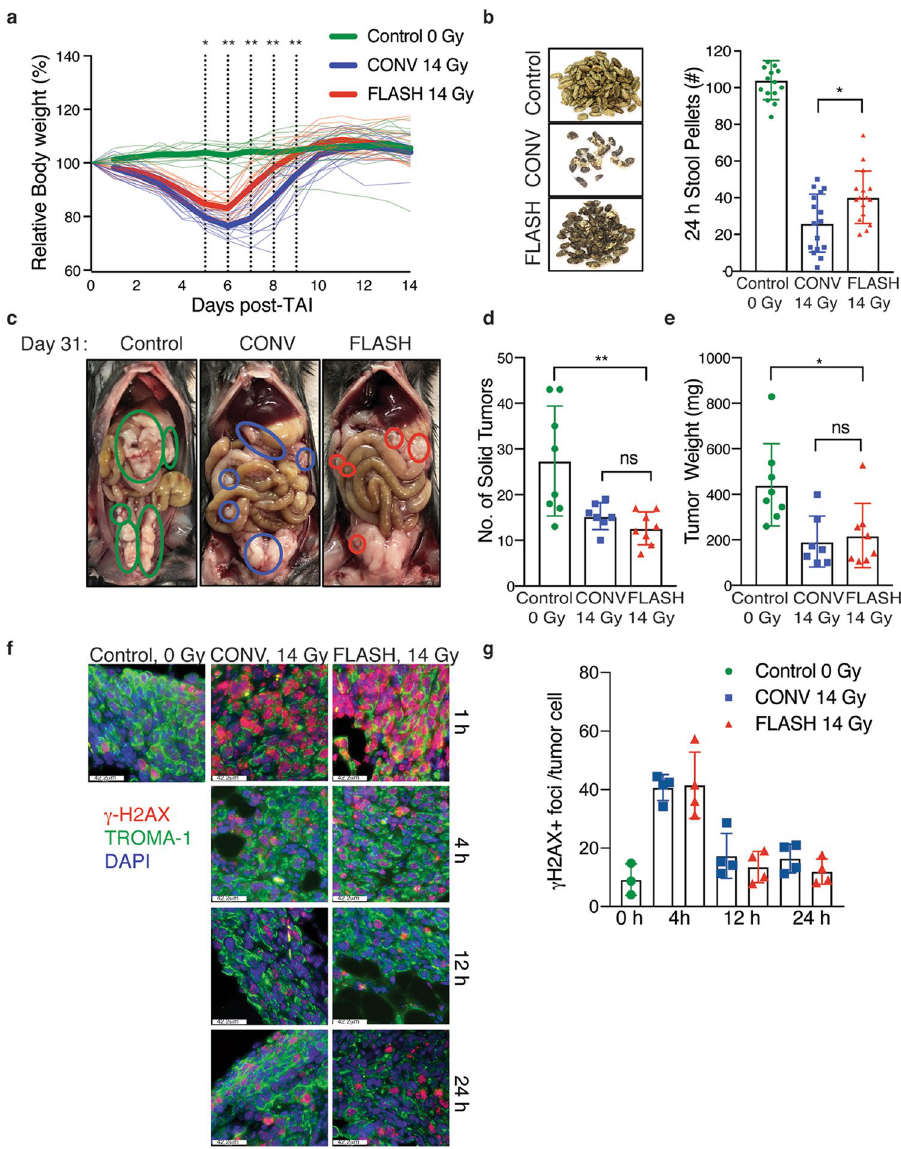
Figure 6. Abdominal FLASH irradiation has similar tumor control efficacy as CONV irradiation and spares intestinal function in a preclinical syngeneic ovarian cancer mouse model. ( a ) Relative body weight (%) of ID8 tumor-bearing mice over time after 14 Gy CONV or FLASH TAI. Bold lines show the average for each cohort. The dotted lines indicate days at which the difference between CONV and FLASH is significant. n = 16 per group. ( b ) Representative images of stool pellets (left) and quantification of the number of stool pellets (right) excreted over 24 h at 15 days after tumor cell injection, or 5 days after 14 Gy abdominal irradiation (n = 16 mice per group), showing increased stools after FLASH vs . CONV irradiation, consistent with the observation in non-tumor bearing mice. ( c ) Representative images displaying metastatic tumor burden in mice that were intraperitoneally injected with ID8 ovarian tumor cells and ( d , e ) quantification of the number of solid tumor nodules ( d ) and total tumor weights ( e ) in control mice and mice irradiated with 14 Gy CONV or FLASH irradiation, demonstrating similar tumor control efficacy with both FLASH and CONV irradiation. n = 8 mice per group; ns no significant difference, *p < 0.05, **p < 0.01; Comparisons by one-way ANOVA followed by Tukey’s multiple comparisons test. Error bars represent standard deviation of the mean. ( f ) Representative γ-H2AX (red), TROMA-1 (green, a marker if ovarian cancer cells) and DAPI (blue) stained images of tumors from ID8 ovarian tumor bearing mice at the indicated time points after sham or sublethal 14 Gy abdominal irradiation. ( g ) Quantification of the average number of γ-H2AX + foci per TROMA-1 positive ID8 cancer cell 4 h, 12 h and 24 h after 14 Gy abdominal irradiation. n = 4 mice per group. An average of 15 TROMA-1 positive cancer cells per mouse were quantified for γ-H2AX foci. At 4 and 12 h after irradiation, γ-H2AX foci in CBCs were similar after FLASH and CONV irradiation and resolved to baseline levels in both groups by 24 h. ns no significant difference, *p < 0.05, **p < 0.01, ***p < 0.001; Unirradiated control versus CONV or FLASH compared by one-way ANOVA followed by Tukey’s multiple comparisons test. Error bars represent standard deviation of the